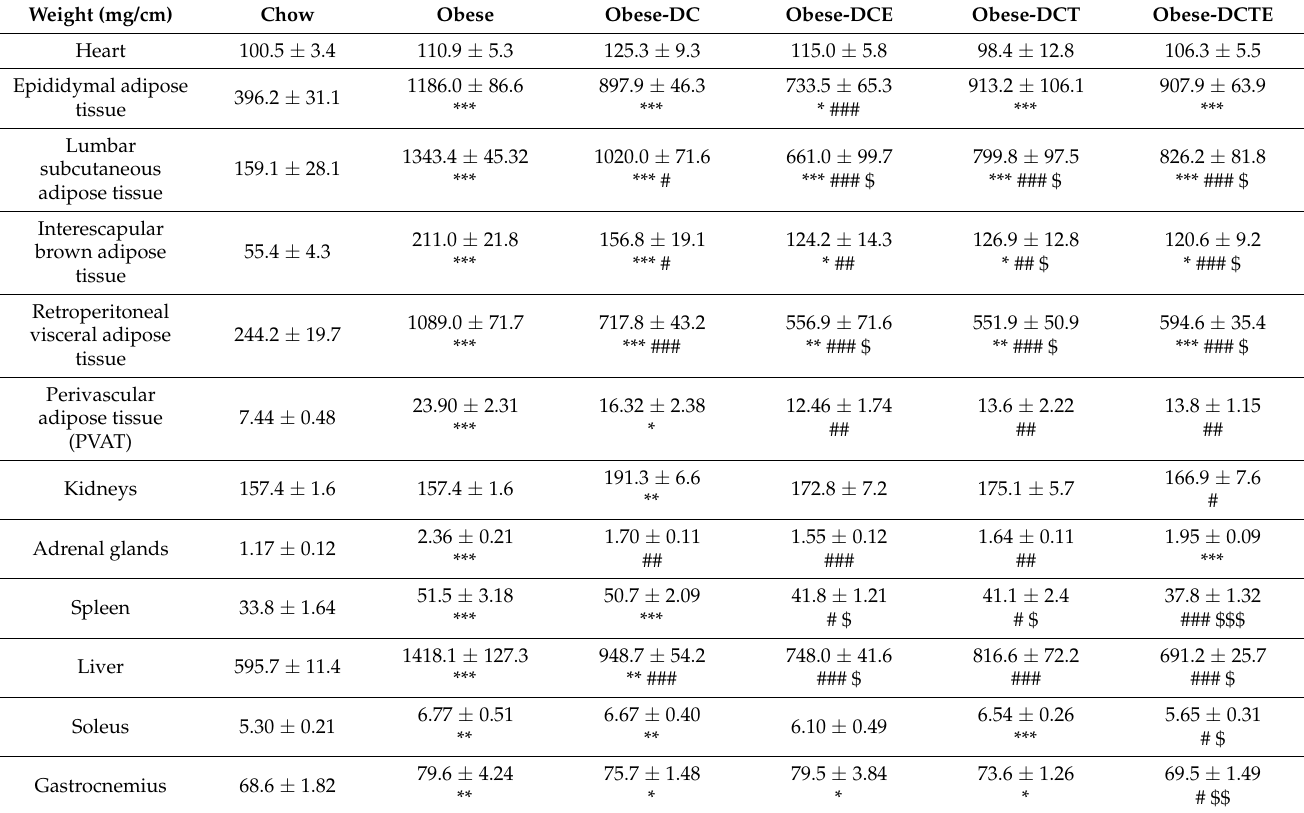
Table 1. Weights of heart, epididymal adipose tissue, lumbar subcutaneous adipose tissue, in- terescapular brown adipose tissue, retroperitoneal visceral adipose tissue, perivascular adipose tissue, kidneys, adrenal glands, spleen, liver, gastrocnemius and soleus muscles. Chow = mice fed a standard diet for 25 weeks; Obese = mice fed a high fat (60% kcal from fat)/high sucrose diet for 25 weeks; DC = mice fed a high fat (60% kcal from fat)/high sucrose diet for 23 weeks and switched to a diet with lower caloric intake (25% kcal from fat) for two weeks; DCE = mice fed a high fat (60% kcal from fat)/high sucrose diet for 23 weeks and switched to a diet with lower caloric intake (25% kcal from fat) supplemented with CSAT+ ® for two weeks; DCT = mice fed a high fat (60% kcal from fat)/high sucrose diet for 23 weeks and switched to a diet with lower caloric intake (25% kcal from fat) and subjected to aerobic training for two weeks; DCTE = mice fed a high fat (60% kcal from fat)/high sucrose diet for 23 weeks and switched to a diet with lower caloric intake (25% kcal from fat) supplemented with CSAT+ ® and subjected to aerobic training for two weeks. Values are represented as mean ± SEM; n = 8–10 mice/group. * p < 0.05 vs. chow; ** p < 0.01 vs. chow; *** p < 0.001 vs.